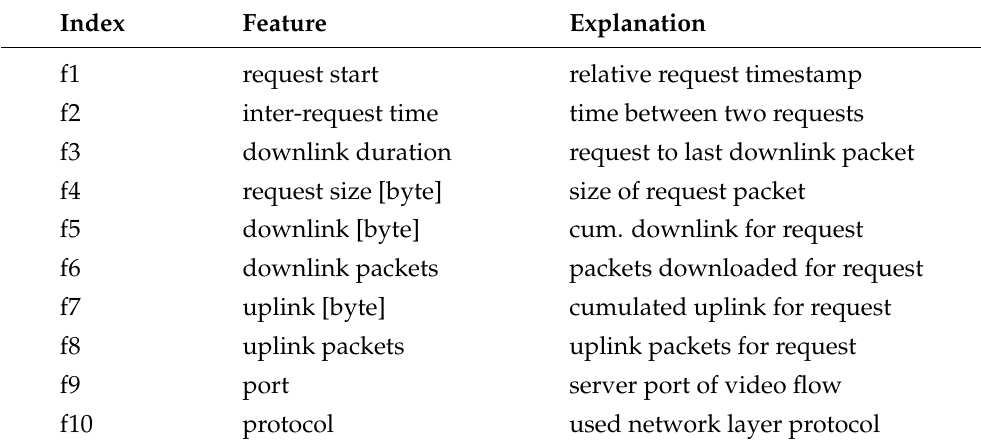
Table 6. Feature overview.